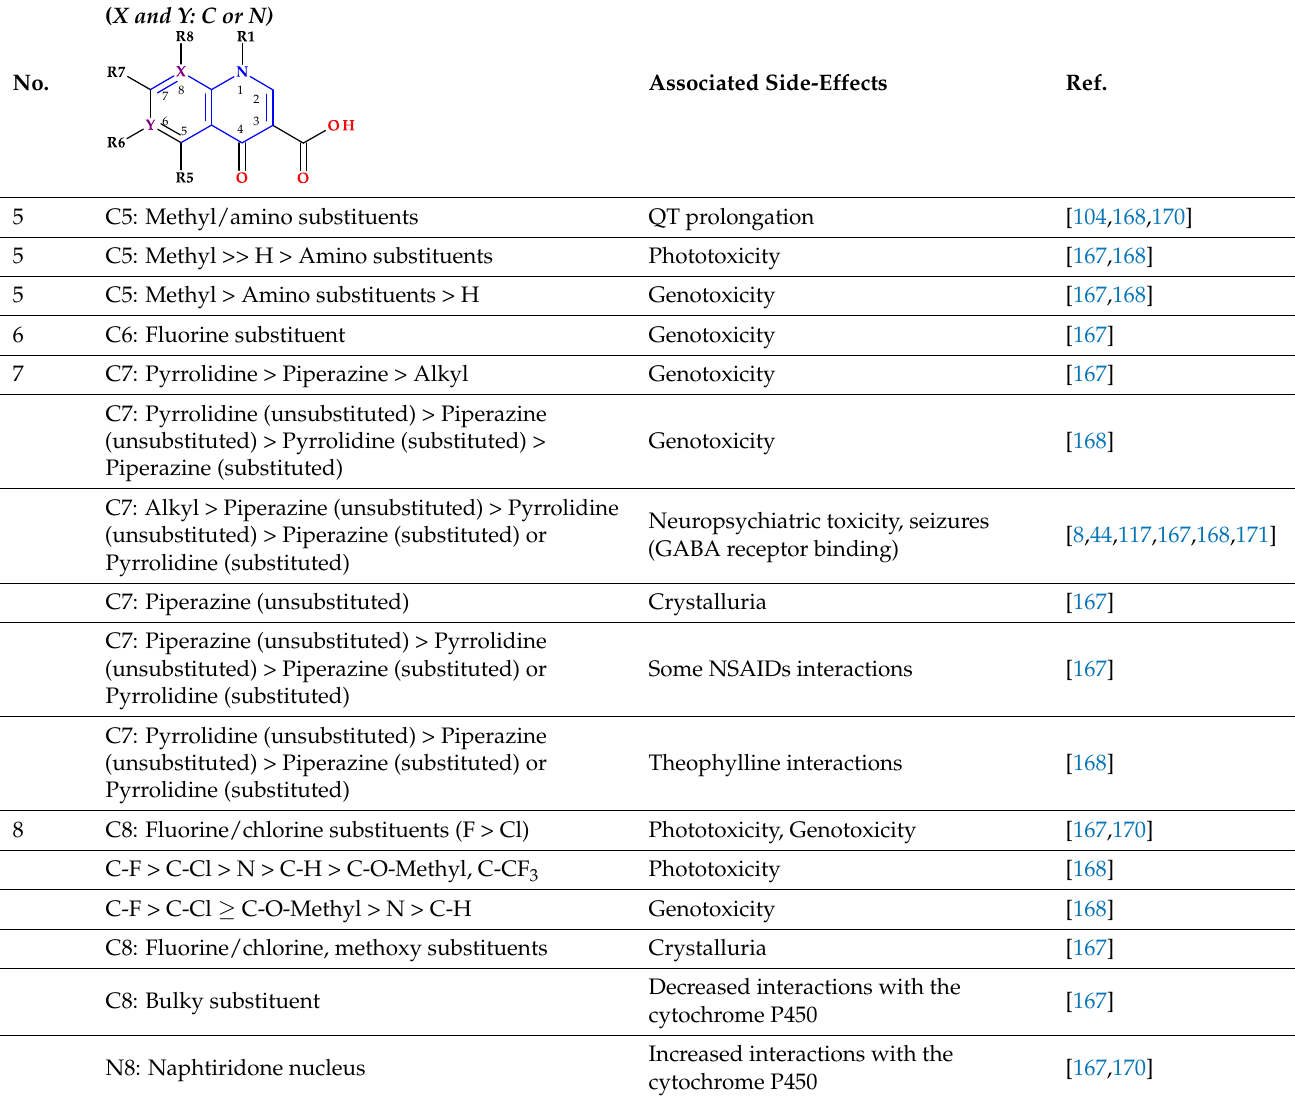
Table 5. Relationships between chemical structure and side-effects of FQs (FQs — fluoroquinolones, GABA — gamma-aminobutyric acid, NSAIDs — non-steroidal anti-inflammatory drugs, Ref. — Refer- Table 5. Cont.